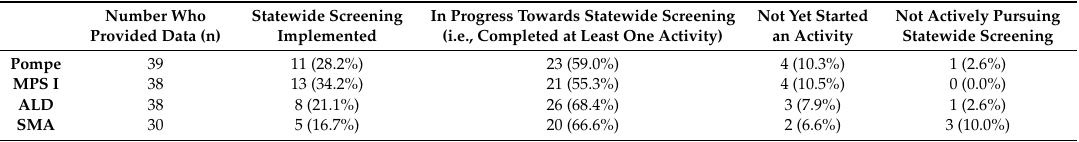
Table 1. Implementation Status of Participating Newborn Screening Programs Collected from the New Disorder Readiness Tool, as of August